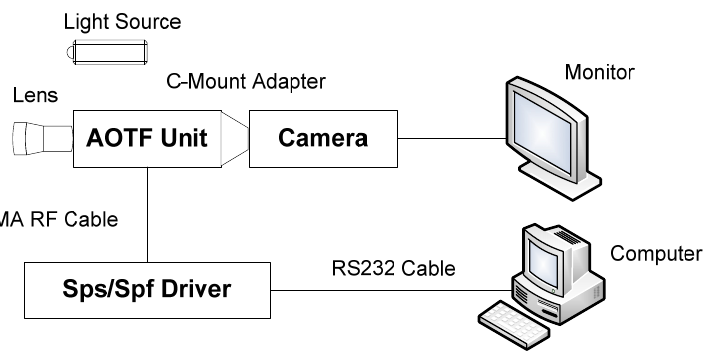
Figure 1. The schematic diagram of the